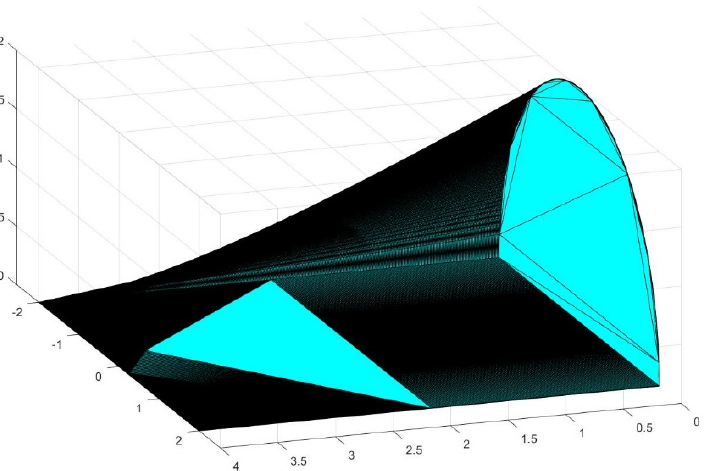
Figure 9. The three surfaces intervening in Example 2 whose area is calculated by computer graphic interpolation.